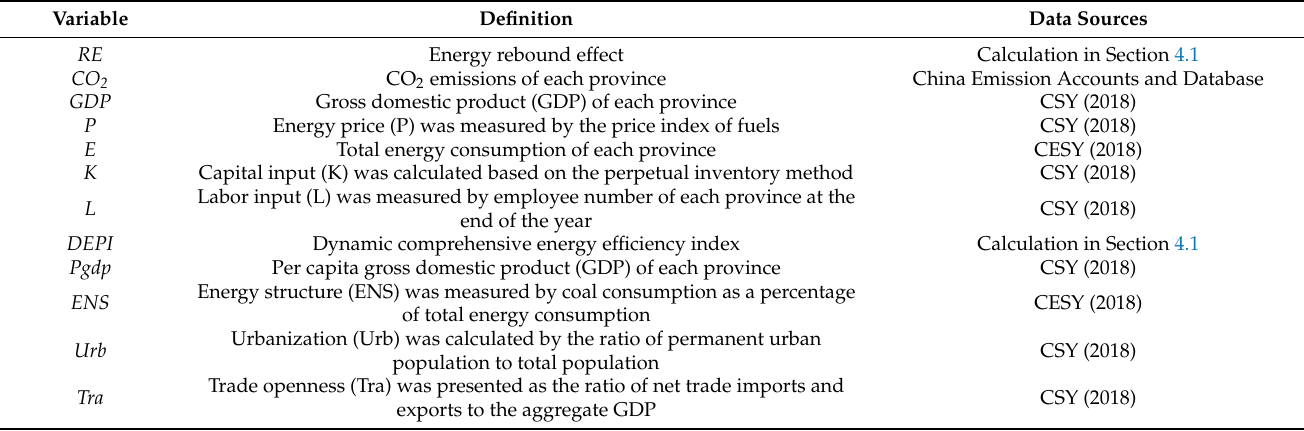
Table A1. Descriptions and data sources of the